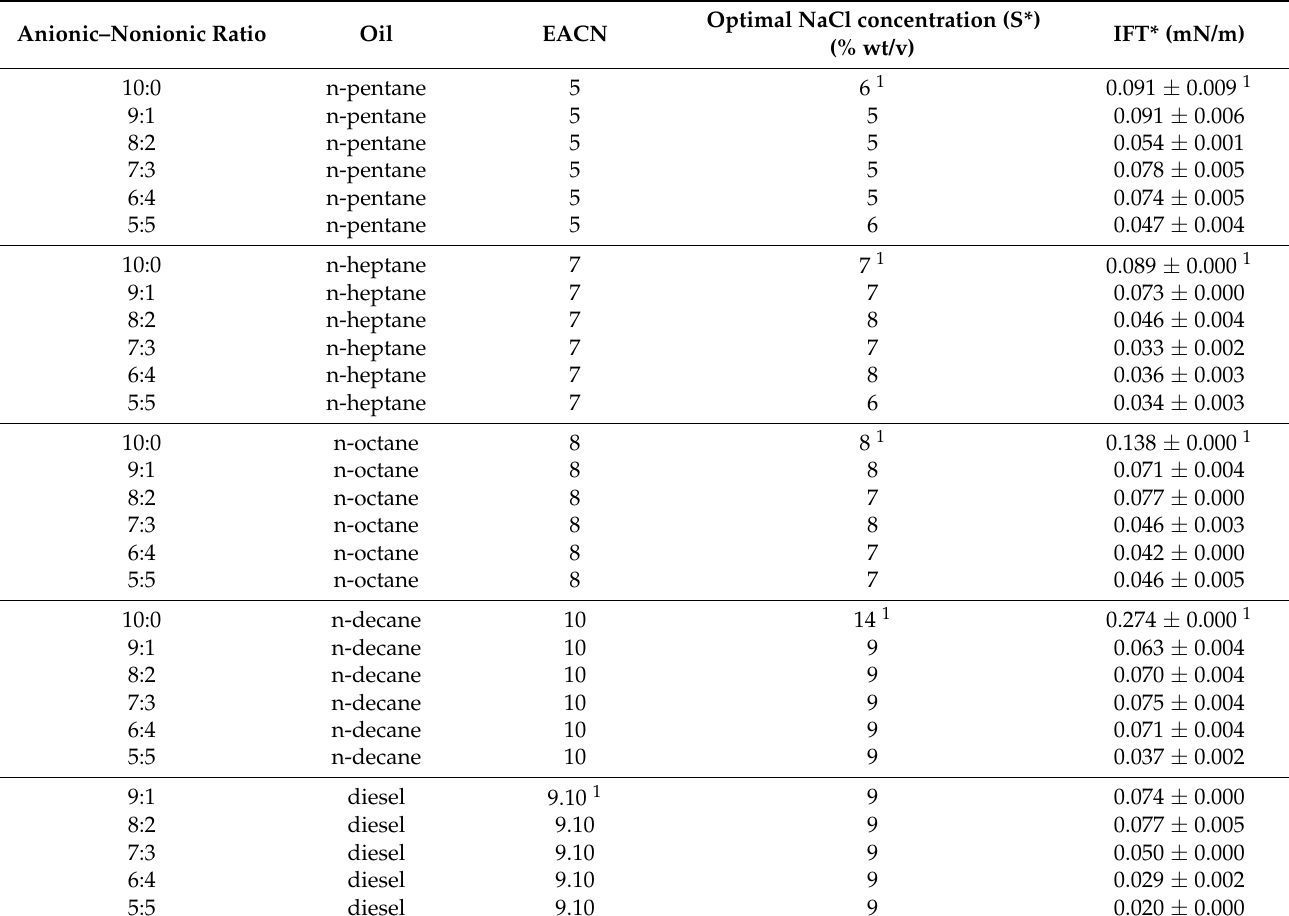
Table 2. Optimal salt concentrations (S*) and optimal interfacial tensions (IFT*) of SDHS-AAE(6EO4PO) systems. Anionic–Nonionic